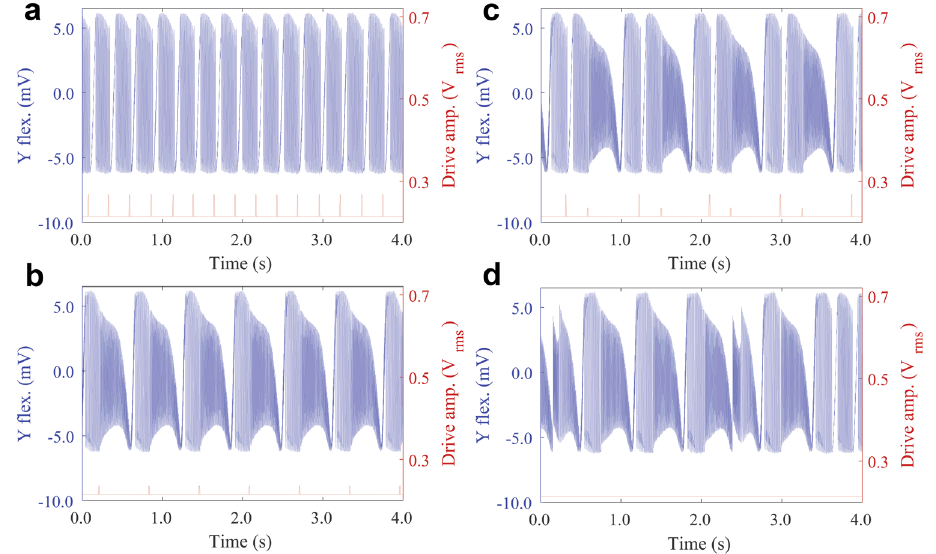
Fig. 4 | Experimental demonstration of the control pulses at the branching point for the selection of RDSs. In the switching regime, the system is close to being captured by either of the two loops. The outcome is, therefore, highly sen- sitive to initial conditions and noise close to the branching point. Hence, by applying a small control pulse (consisting of a change in drive strength of the harmonic drive away from the baseline at 0.214V and drive frequency fi xed at 64333.0Hz) with a duration of ~10ms at the branching points (red curve